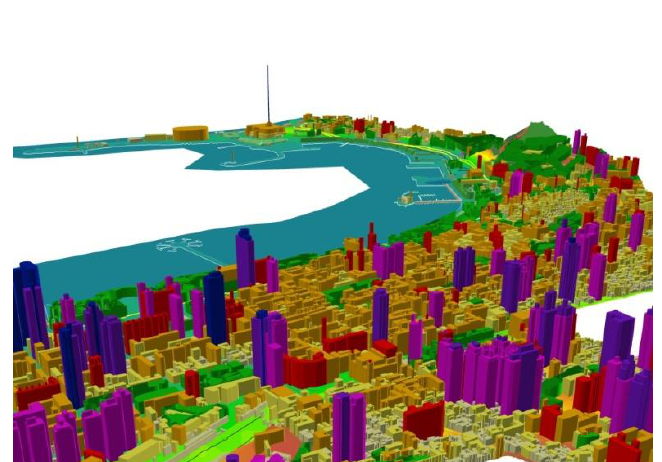
Figure 4. The visual view of the buildings in Baku city. After entire completion of the vectorization process the clutter classes were identified (table 1) and clutter model was created (figure 5). Clutter model consists of 20 classes and reflects 10 classes of construction areas, 3 classes of water bodies, 7 classes of landscape and vegetation